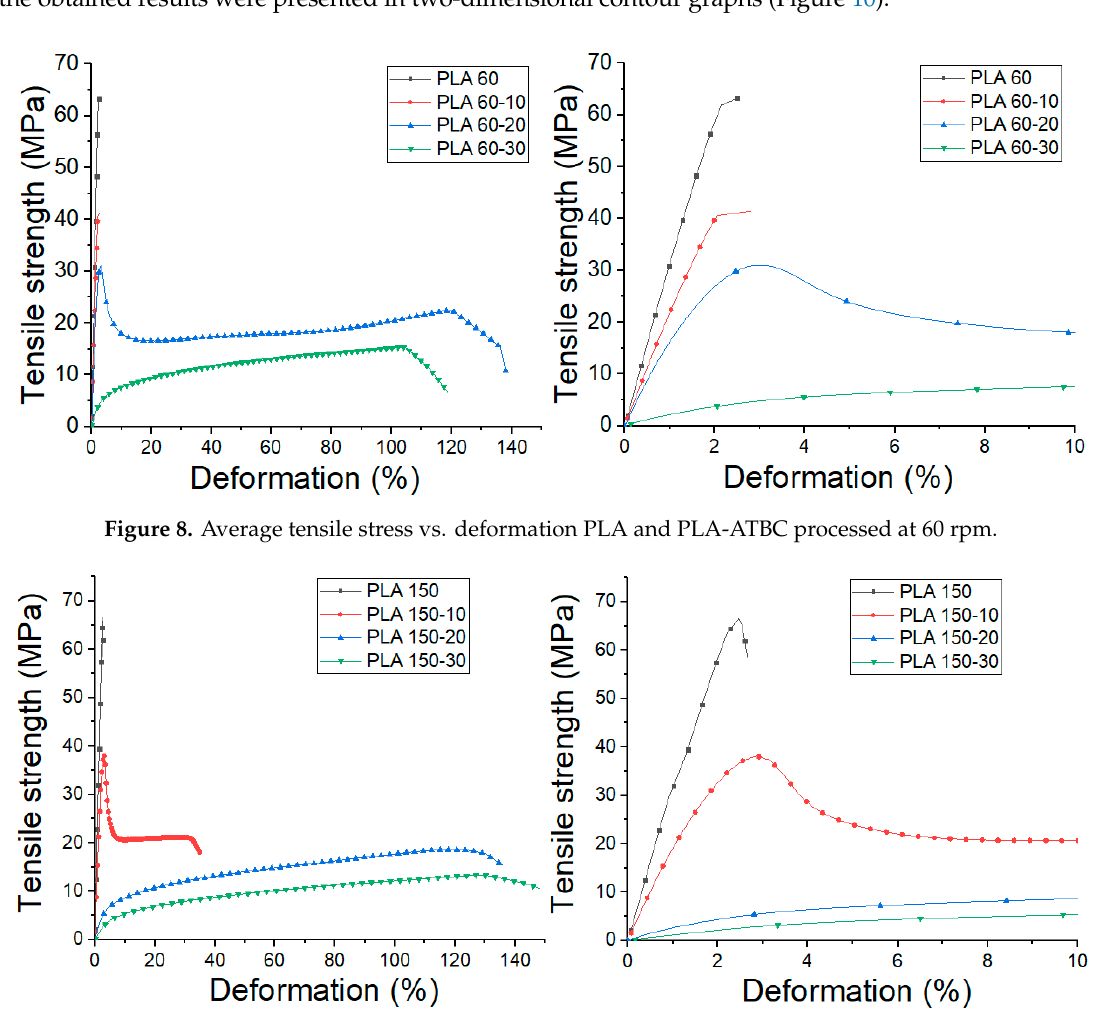
Figure 9. Average tensile stress vs. deformation PLA and PLA-ATBC processed at 150 rpm. Table 2. Mechanical properties of the studied materials.